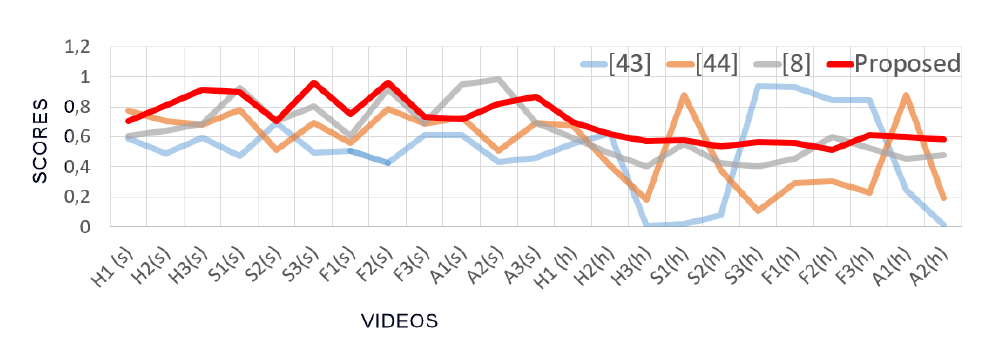
Figure 17. Comparison of the scores computed by different approaches on two subsets of videos containing strongly and hinted execution of facial expressions.